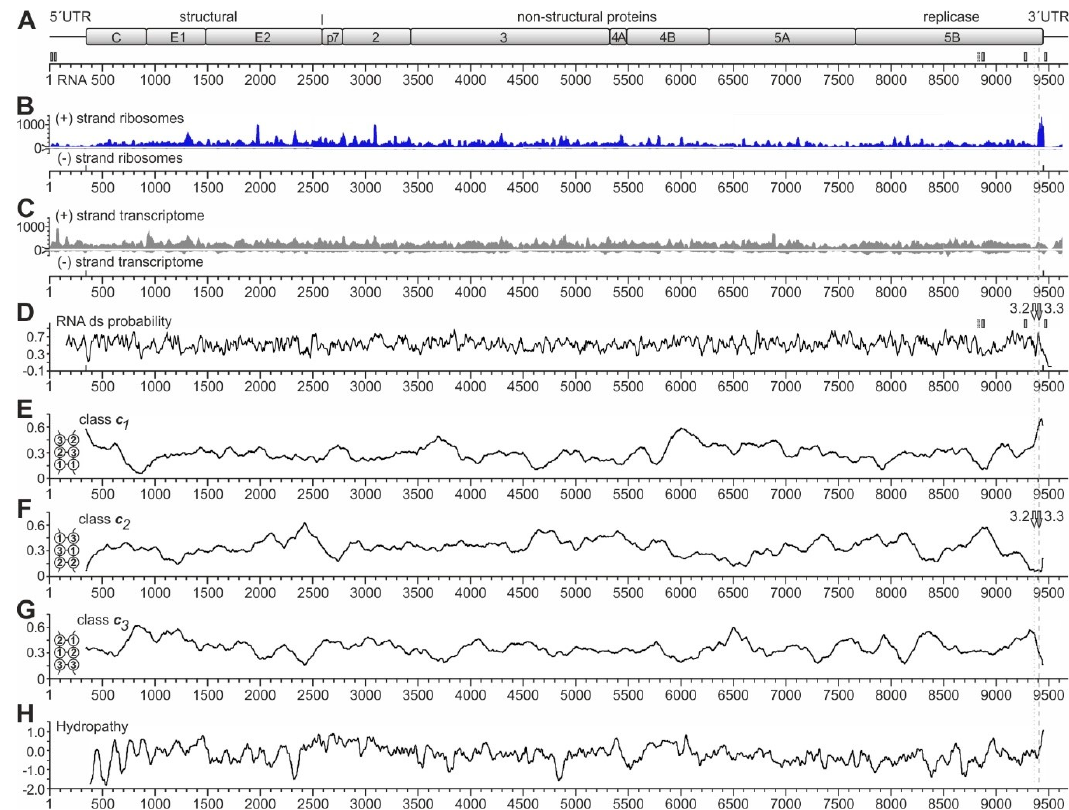
Figure 2. Ribosome profiling of the HCV RNA genome replicating in Huh-7.5 cells. ( A ) The HCV genome with the polyprotein coding regions for structural and non-structural (NS) proteins. The numbering shows nucleotide numbers of the Jc1 genome [56]. Two conserved miR-122 target sites in the HCV 5´UTR, sites 5B.2 and 5B.3 in the NS5B coding region, and the 3´UTR target site are shown as small boxes with solid lines, the non-conserved site 5B.1 as a box with dashed line [43,59]. ( B ) Ribosome profiling reads of the HCV plus ( + ) strand ribosomes and ( − ) strand ribosomes. ( C ) Transcriptome reads of the HCV plus ( + ) strand (upper panel) and ( − ) strand (lower panel). ( D ) RNA double-strand (ds) probability. miR-122 target sites in the 3´region are indicated. The positions of the stem-loops 5BSL3.2 and 5BSL3.3 are indicated by white and grey arrows, respectively, and dotted and dashed grey lines indicate their position relative to the ribosome peaks at the stop codon. ( E – G ) The frequencies of RNA secondary structure classes in which opposing codons would be required to pair (as shown in the inserts) were calculated for conserved HCV sequences [60]. For example, in class c1, position 1 of one codon would be required to pair with position 1 of an opposing codon, whereas in class c2, position 2 of one codon would be required to pair with position 2 of an opposing codon [60]. Windows of 200 nucleotides (nts) were moved in steps of 5 nts, and for each nucleotide, the means of class frequencies are calculated from all windows containing this given nt. As a result, the plots show if a certain RNA secondary structure class is under-represented due to selection pressure, which would suggest the presence of a functional RNA secondary structure [60]. Thereby, under-representation of RNA secondary structure class c1 indicates the general importance of codon position 1 to determine a specific amino acid, whereas under-representation of class c2 indicates the importance of codon position 2, which often determines hydrophobic amino acids in membrane standing protein regions [60]. In ( F ), the positions of the stem-loops 5BSL3.2 and 5BSL3.3 are indicated as in ( D ). ( H ) HCV polyprotein hydropathy plot [61], smoothened by plotting hydrophobicity means of sliding windows of 3 amino acids.